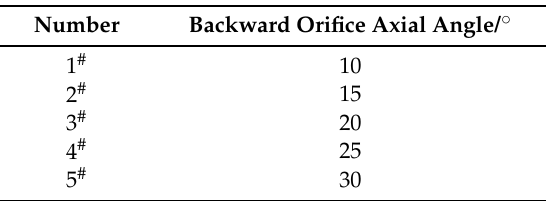
Figure 12. Self-propelled nozzles with different backward orifices axial angles. Backward orifice axial angles for five self-propelled nozzles used for self-propelling force